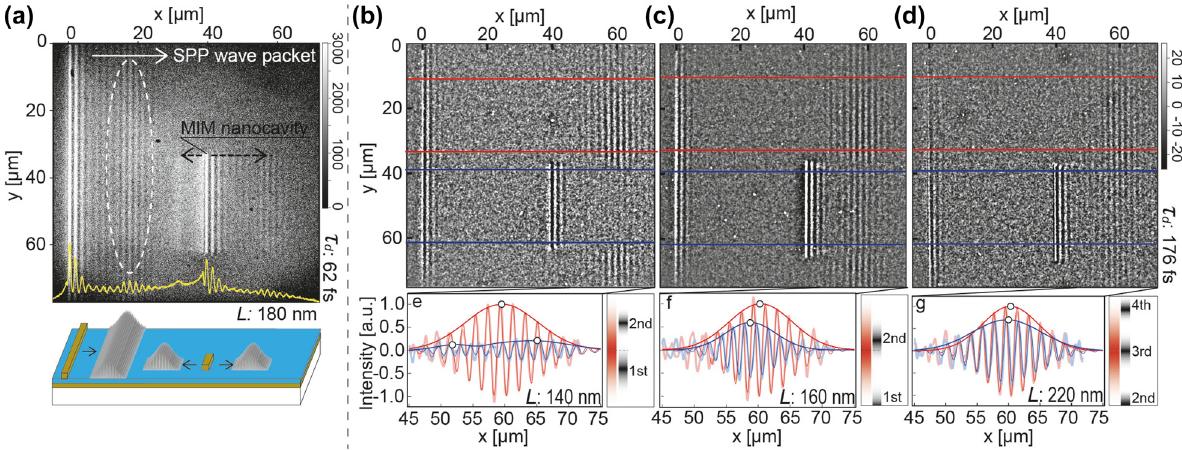
Figure 2: Fluorescence images of SPP WPs. (a) Selected frame of time-resolved two-photon fluorescence movie ( τ d = 62 fs) and cross section taken along x- direction (yellow line). (b) – (d) Time-resolved micrographs of SPP WPs transmitted through MIM-NCs with length L = (b) 140 nm, (c)160nm,and(d)220nmfor( τ d